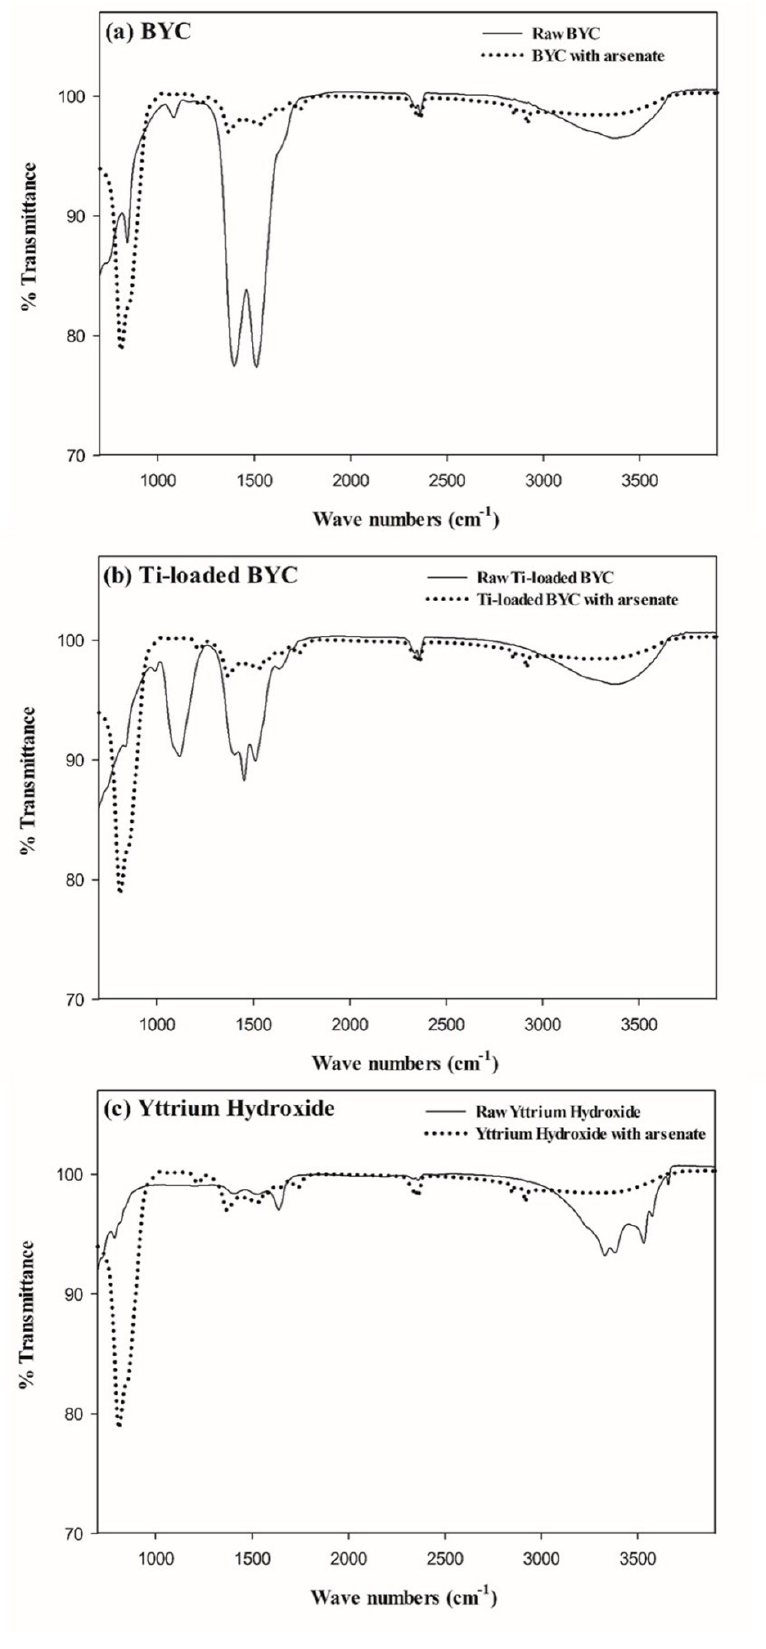
Figure 5. Variation of Fourier Transform IR spectra in BYC ( a ), Ti-loaded BYC ( b ), and yttrium hydroxide ( c ) by reaction with arsenate (black line: raw materials, dotted line: reaction with